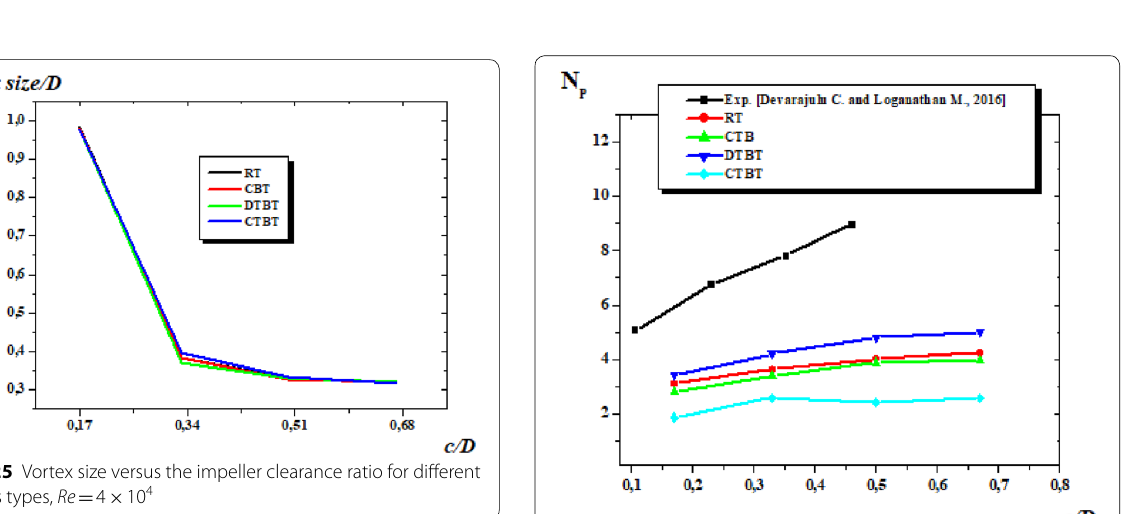
0.25 and Re 4 10 4 = = ×